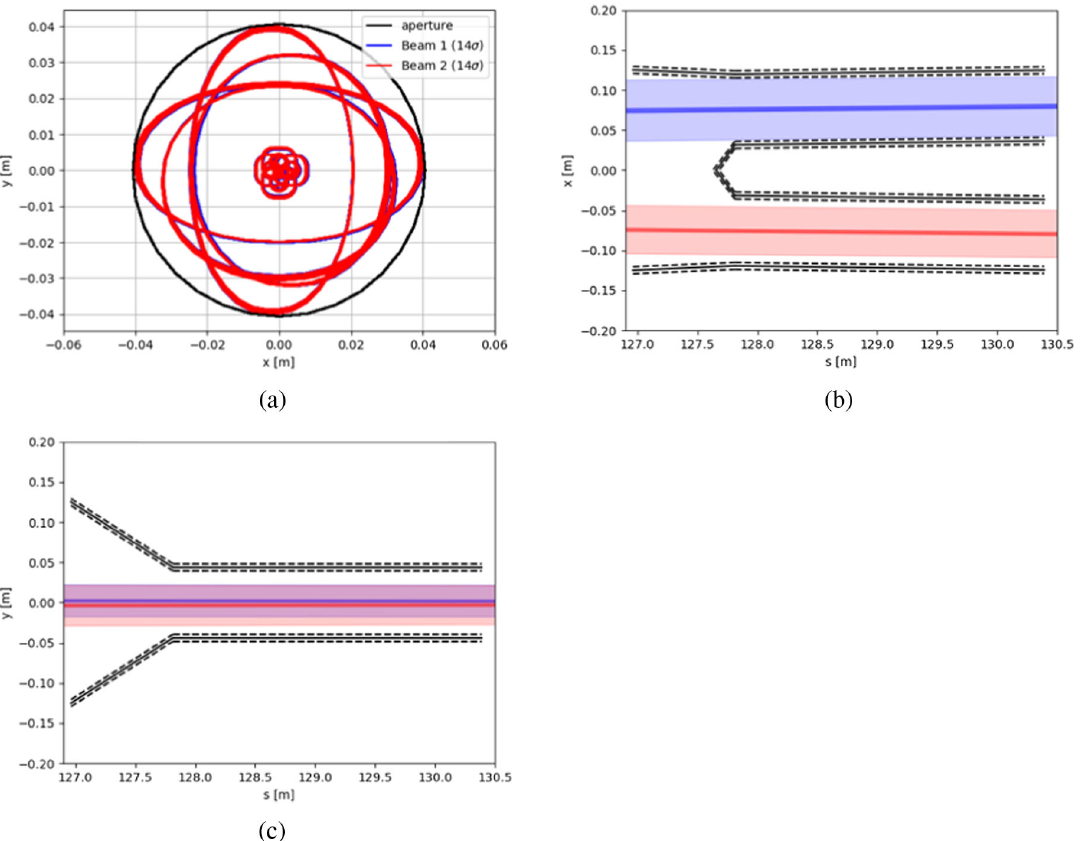
FIG. 3. Beam size inside the 88 mm internal diameter double pipes of the recombination chamber for flat optics at 14 . 0 σ . (a) Vertical transverse cross-section of the particles beam. (b) Longitudinal horizontal cross-section of the particles beam on the right side of CMS. (c) Longitudinal vertical cross-section of the particles beam on the right side of